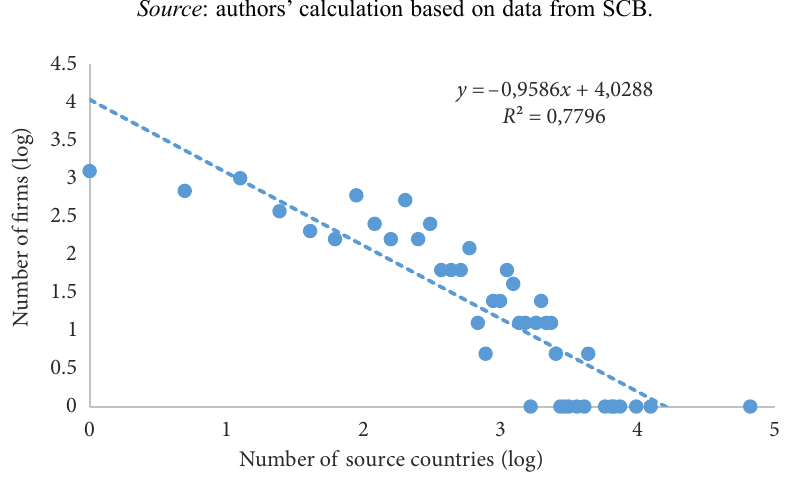
Fig. 2. Distribution of manufacturing firms in the ICT sector according to the number of source countries from which firms source inputs. In the figure a dot indicates the number of firms importing from a given number of source countries Source : authors’ calculation based on data from